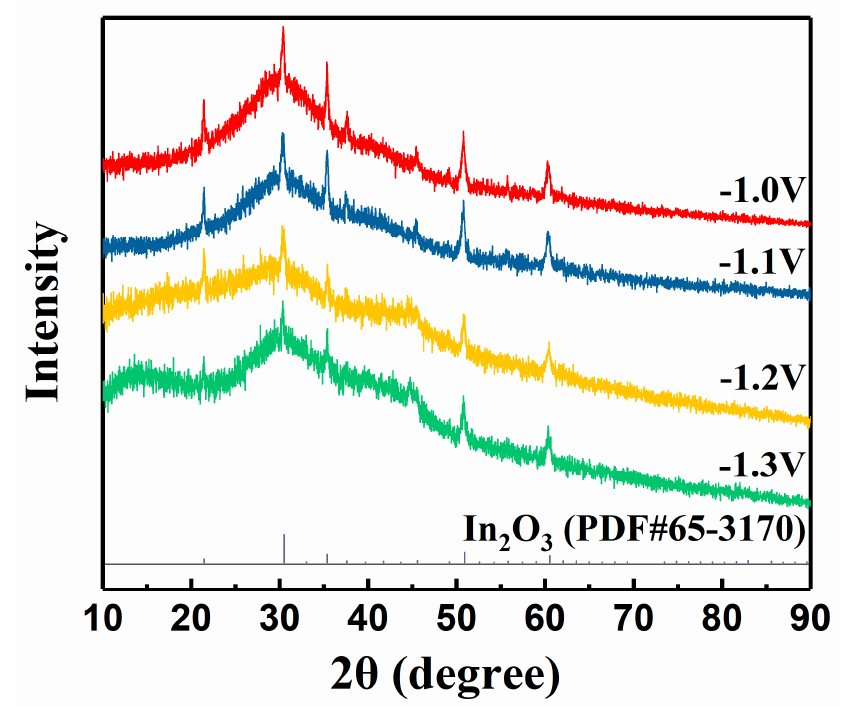
Figure 1. XRD patterns of precursor films deposited at different potentials.